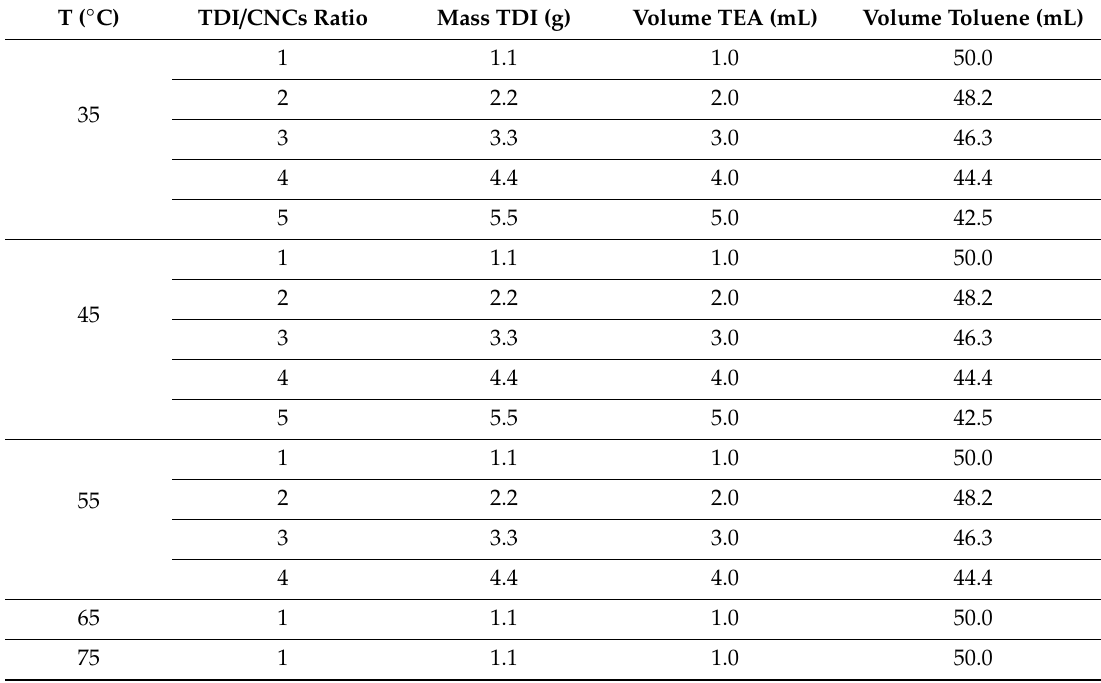
Table 1. The carbamation conditions and the corresponding amounts of reactants, catalyst, and solvent. Time and CNC amount were kept constant (24 h and 1.0 g,